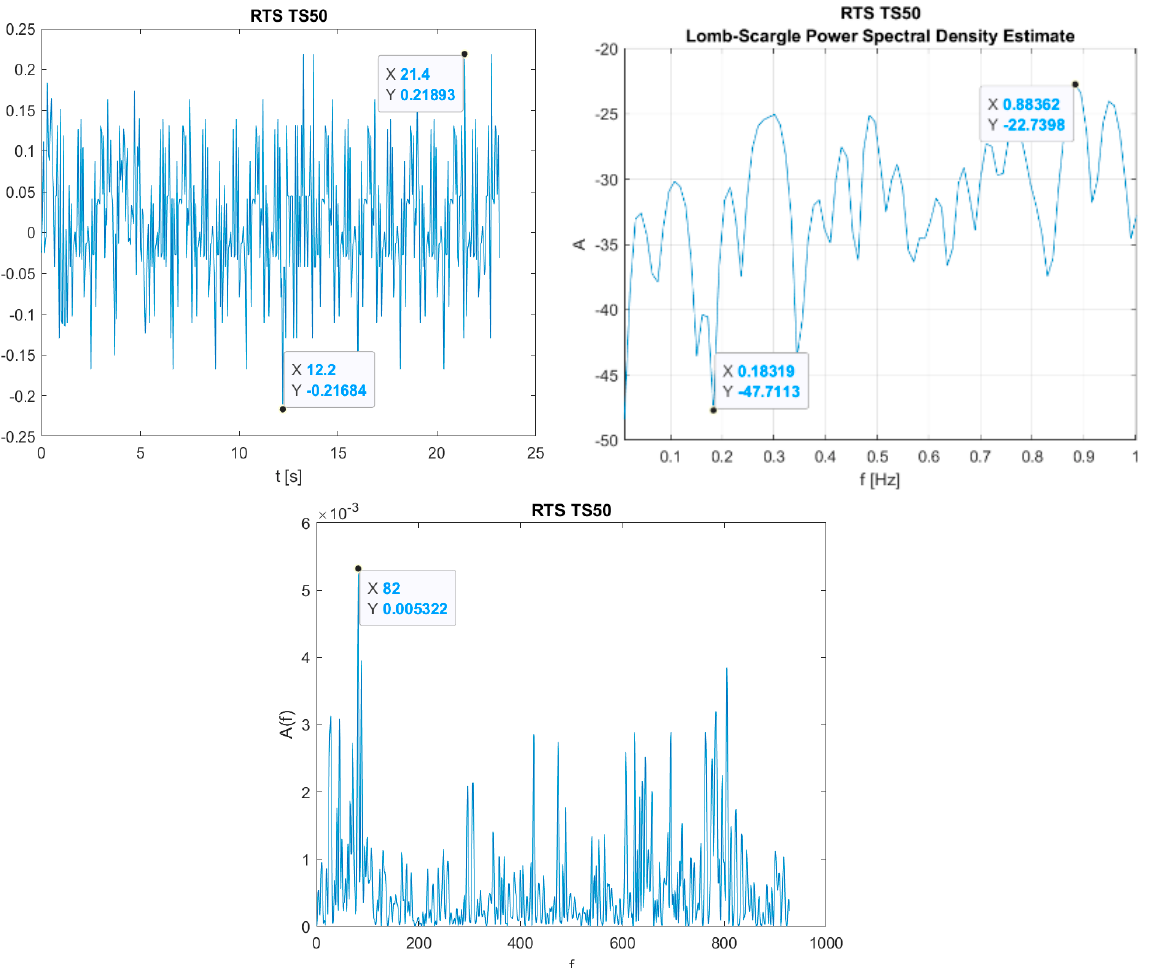
Figure 15. Maximum corresponding values and absolute differences of the Lomb–Scargle spectral approximation in the frequency range from 0 to 1 Hz. Table 8. Numerical differences of the Lomb–Scargle spectral approximation in the frequency range from 0 to 1 Hz.